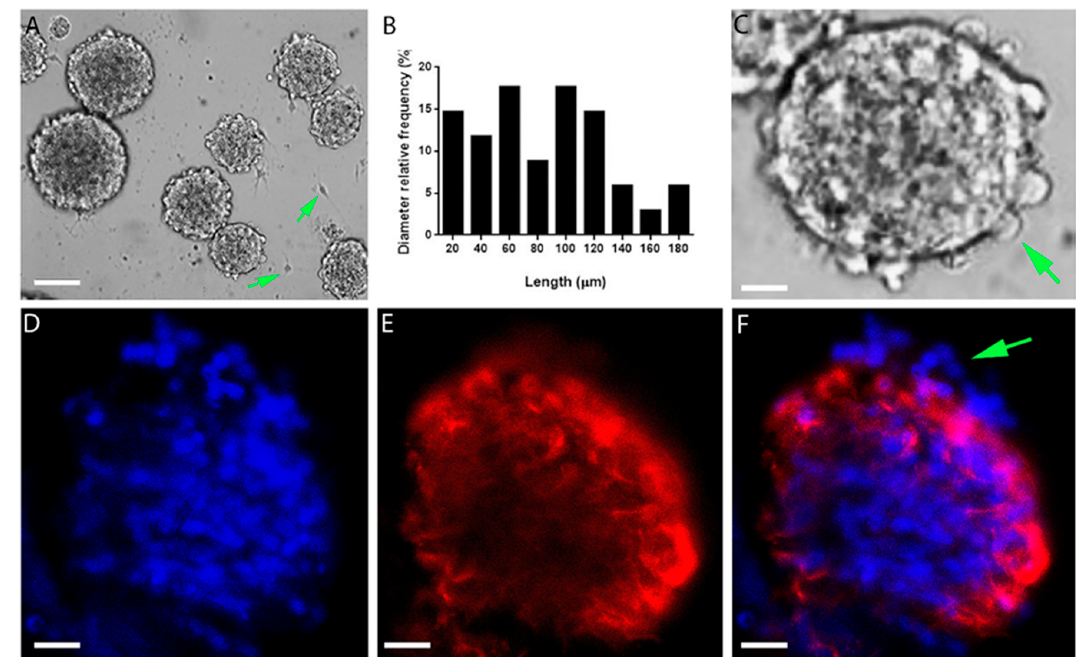
Figure 1. Astrocytes are confined to the periphery of suspended neurospheres. ( A ) Neurospheres in suspension. Arrows point to cells growing out of the neurospheres. ( B ) Distribution of neurosphere diameters. ( C ) Individual cells protruding from the main structure (example indicated by the green arrow). ( D – F ) Cell nuclei (DAPI, blue), GFAP (red). Arrow in ( F ) indicates a cell protruding from the surface. Scale: ( A ) — 100 µ m; ( C ) — 20 µ m; ( D – F ) — 25 µ m.